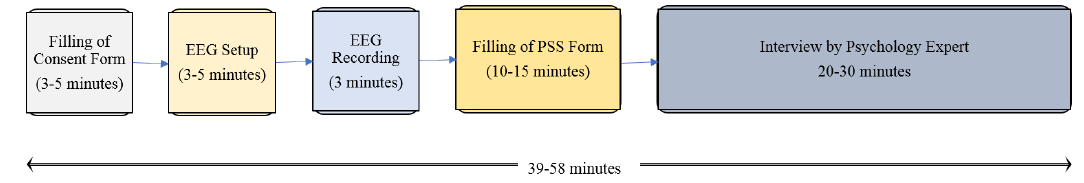
Figure 2. Experimental sequence and the data acquisition